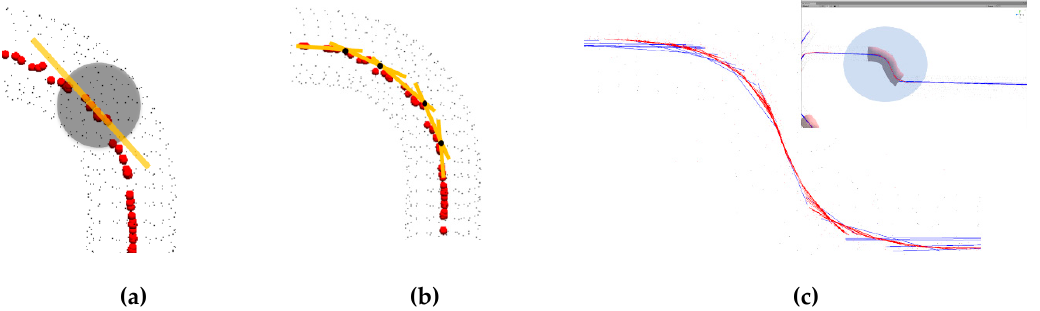
Figure 8. Control point estimation using PCA: ( a ) estimation of tangent line at one point; ( b ) estimation of spline control point using intersection of tangent line; ( c ) curve matching result.